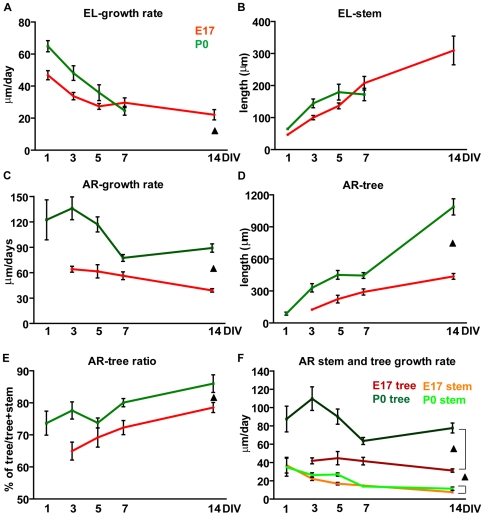
Axonal features and growth of elongating and arborizing Purkinje cells in embryonic or postnatal cultures.(A) The growth rate of both embryonic (E17) and postnatal (P0) elongating (EL) cells progressively decreases during the time in vitro, but postnatal axons lengthen faster than their embryonic counterparts during the first week in culture (two way ANOVA, main effect of population P = 0.03). (B) the lengths of stem neurites of both E17 and P0 PCs are similar until 7 DIV (two way ANOVA, F1,269 = 2.94, P = 0.09), but during the second week E17 axons grow significantly longer than P0 ones (at 7 DIV, Student's t test, P = 0.01). (C–E) Postnatal arborizing (AR) cells extend their neurites faster than E17 PCs (C) and display tree length (D) and tree ratio (E) values consistently higher than embryonic neurons (two way ANOVA, P<0.001). (F) Amongst AR PCs, postnatal arbors expand faster than those of E17 cells (two way ANOVA, F1,243 = 80.72, P<0.01). Conversely, the elongation of the stem compartment in AR cells progresses at a similar pace for both E17 and P0 PCs (two way ANOVA, P = 0.09). However, at both ages stem elongation is slower than the enlargement of the terminal tree (two way ANOVA, P<0.001). Missing points in the plot lines are due to the absence of cells the relevant class at specific culturing times. Error bars, SEM. Black triangle: significant main effect of population.